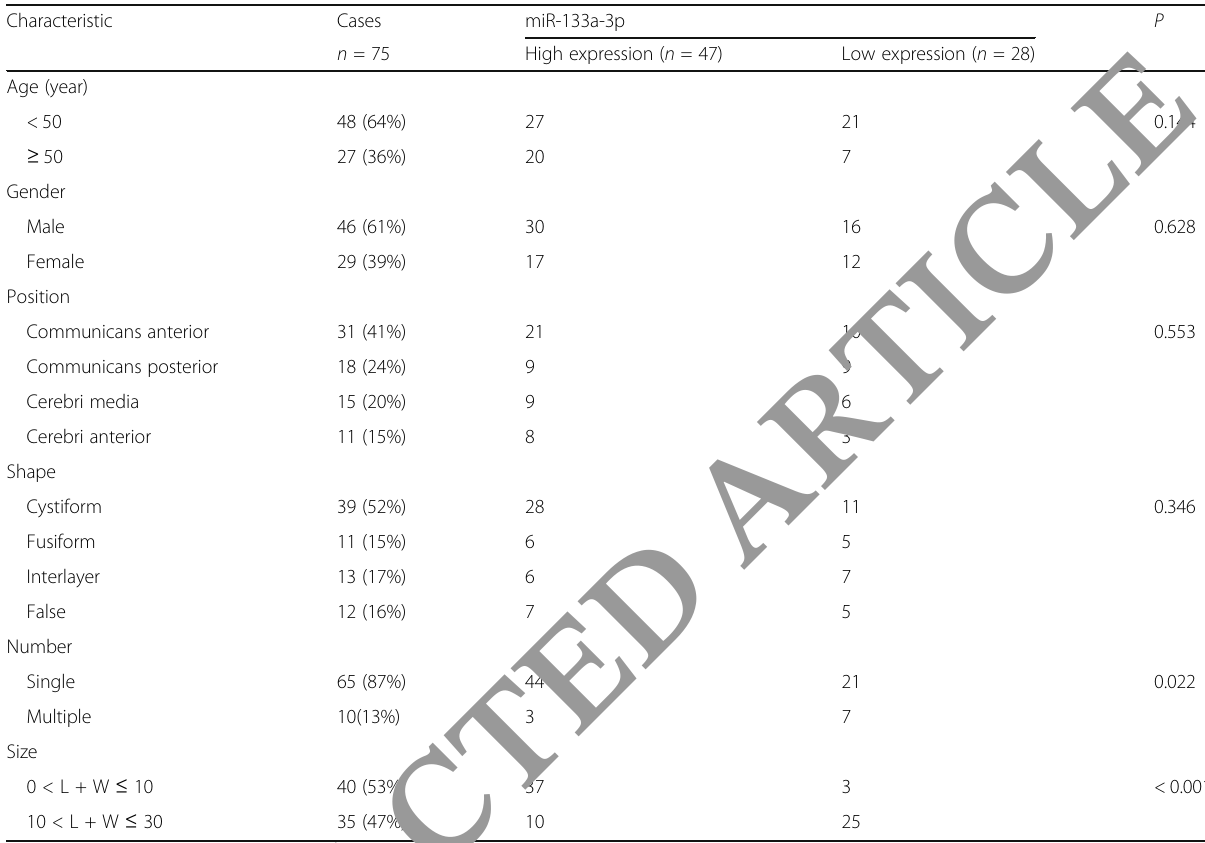
Table 3 Correlation between miR-133a-3p expression and clinicopathological features of IA Characteristic Cases miR-133a-3p